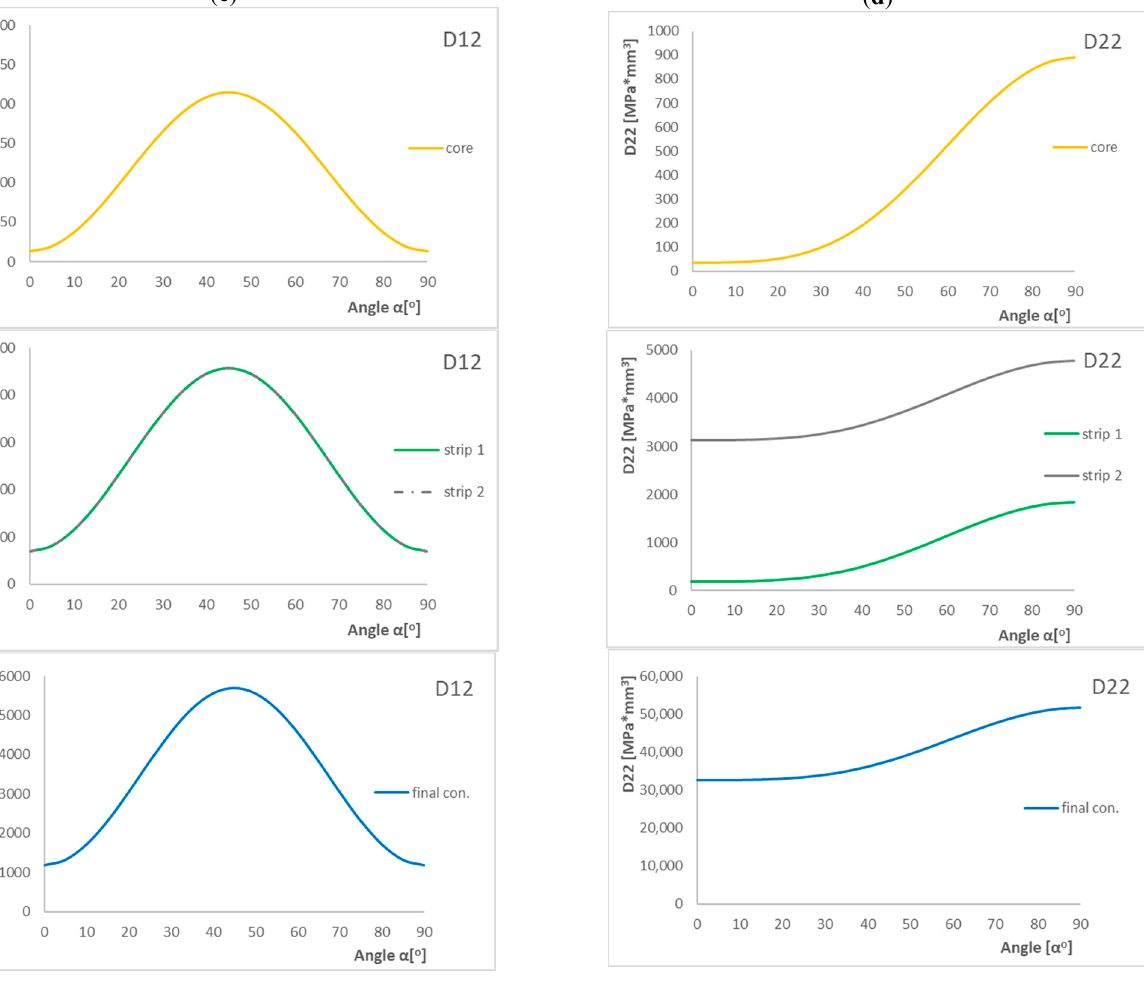
Figure 8. Influence of layer angle α in laminate with PN1 stacking sequence on the ( a ) D 11 , ( b ) D 16 , ( c ) D 12 , and ( d ) D 22 components.